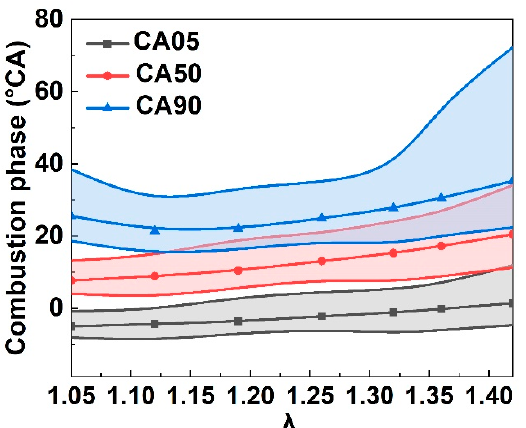
Figure 8. Combustion phase and fluctuation under different λ .